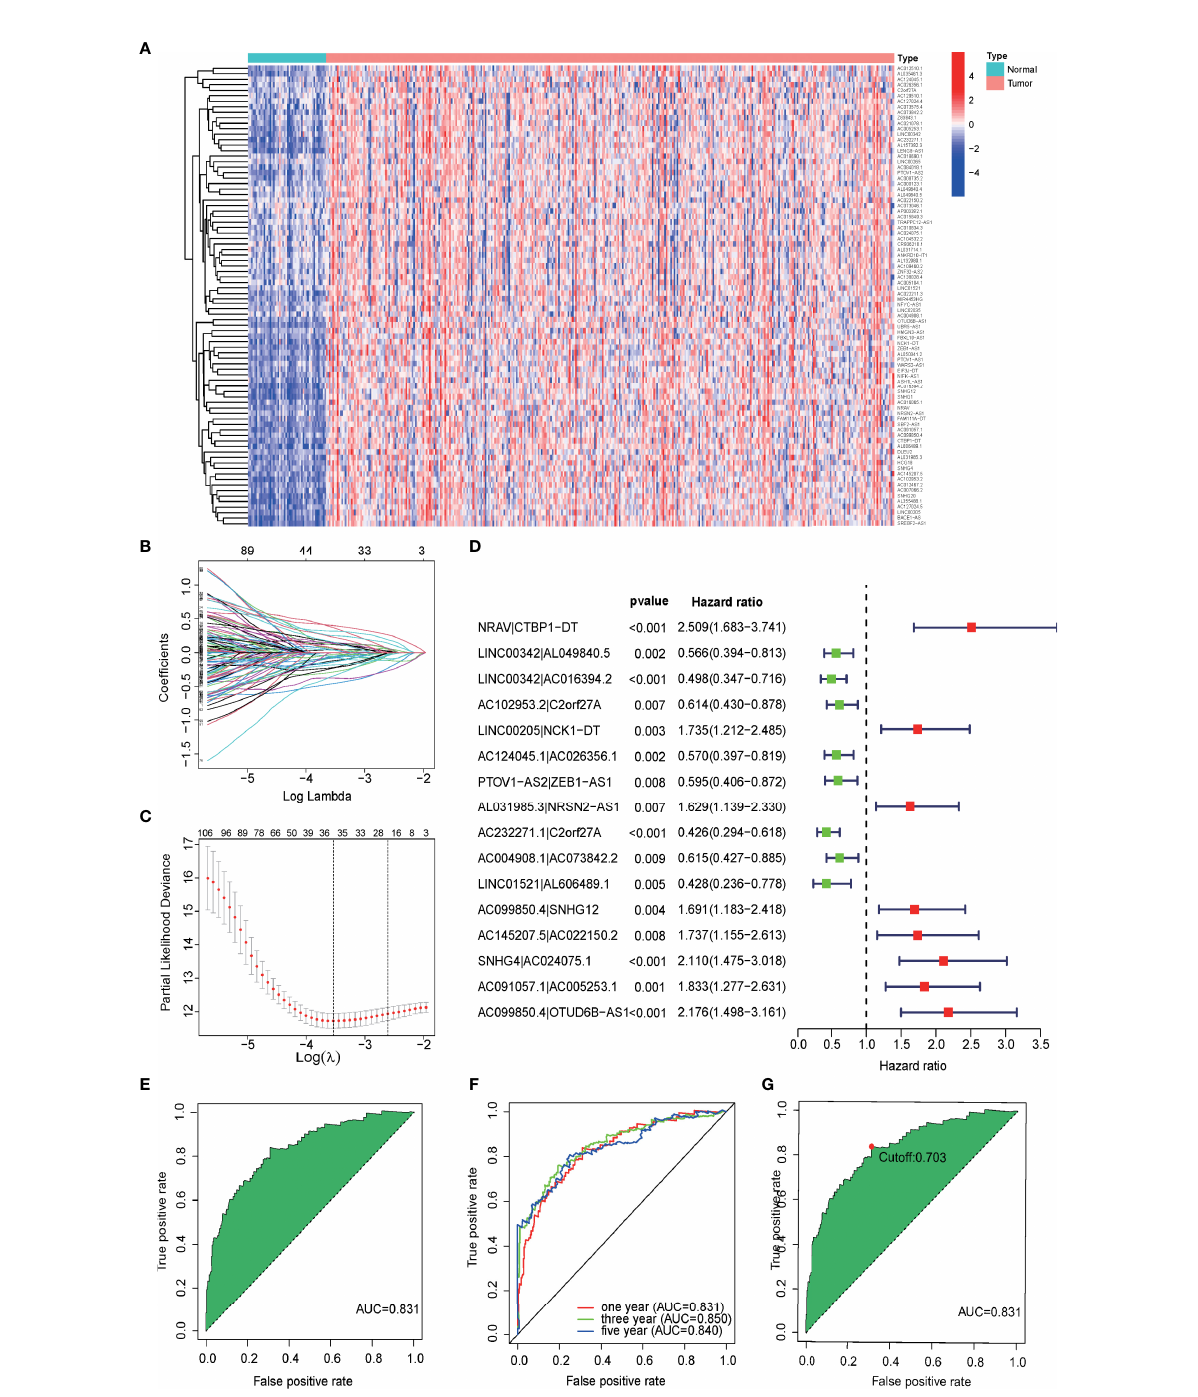
FIGURE 2 Construction of a prognostic signature based on mfrlncRNA pairs. (A) Heatmap of 84 differentially expressed mfrlncRNAs between normal and tumor groups (FDR = 0.05, logFC = 1). (B) Crossvalidation for tuning parameter selection in the LASSO model. (C) LASSO coef fi cient pro fi les of 35 mfrlncRNA pairs. (D) The forest map indicated 16 mfrlncRNA pairs identi fi ed by Cox regression, used for the construction of the mfrlncRNA signature. (E) The ROC of mfrlncRNA signature, whose maximum AUC value was 0.831. (F) The 1-, 3-, and 5-year ROC of the optimal model was 0.831, 0.850, and 0.840, respectively. (G) Risk scores for 365 patients with HCC; the maximum in fl ection point was the cutoff point (cutoff = 0.703). mfrlncRNA, m6A- and ferroptosis-related lncRNA. LASSO, least absolute shrinkage and selection operator; OS, overall survival; HCC, hepatocellular carcinoma; ROC, receiver operating characteristic curve; AUC, area under the